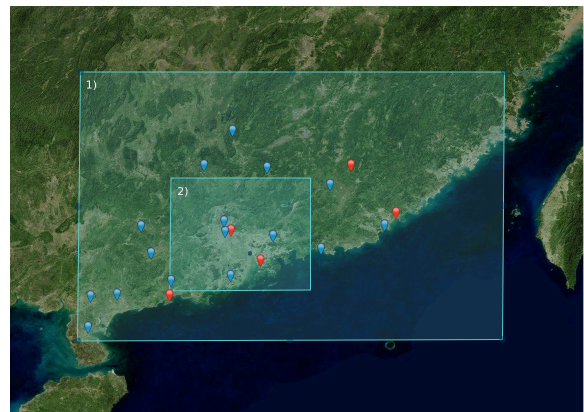
Fig. 5. Domains considered in the model simulations. The outer domain (1) has the size of 900km × 600km with a 3km horizon- tal resolution and is centered at (23.5 ◦ N, 114 ◦ E). The inner do- main (2) provides a finer resolution of 1km and covers a 300km × 300km area, with the center at (22.8 ◦ N, 113.5 ◦ E). The red sym- bols represent the radar stations, and the blue symbols represent the lightning detection stations.